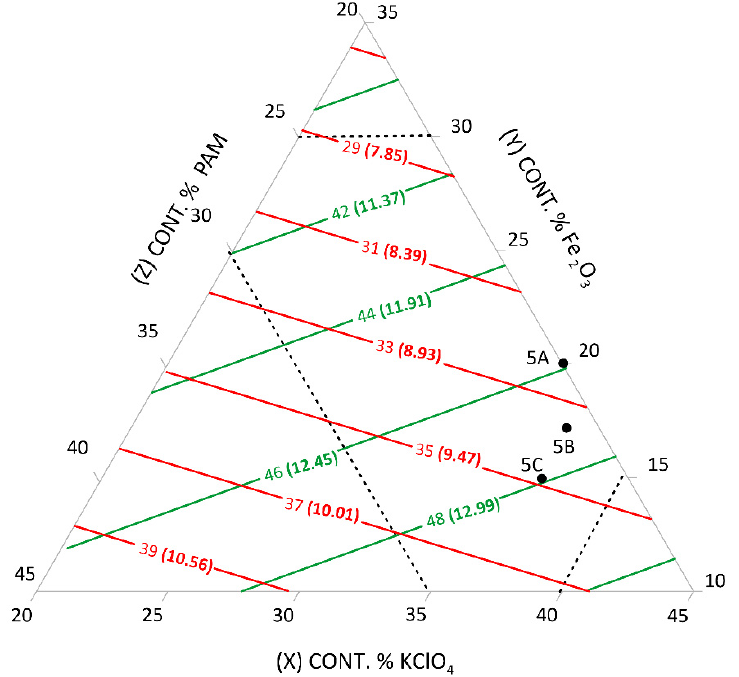
Figure 5. Relationship between costs of the composition (USD/kg): red line—1981, green line—2021; and the content of pyrotechnic composition components (%). Sides of the triangle, with fixed sulphur content S = 25%.